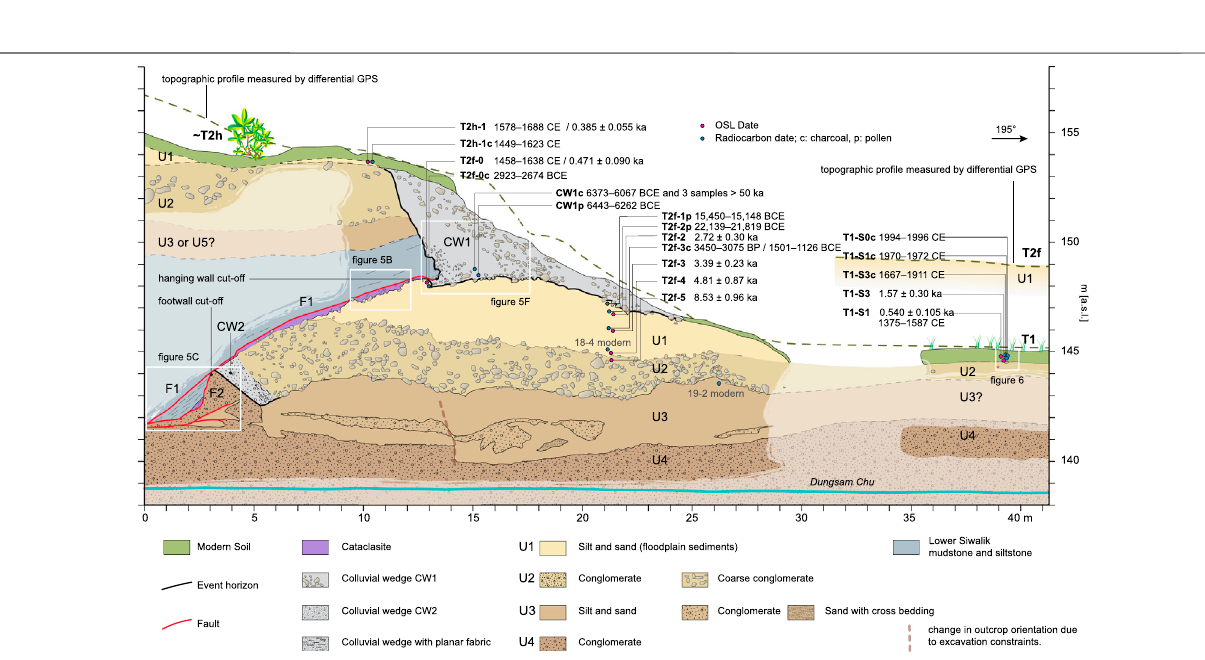
labeled U4, U3, U2, and U1 from oldest to youngest ( Figure 4 ). Unit U4 is a clast-supported fl uvial conglomerate composed of poorly sorted and poorly rounded granules, pebbles, and cobbles in a sandy matrix ( Supplementary Figure S3A ). The sandy